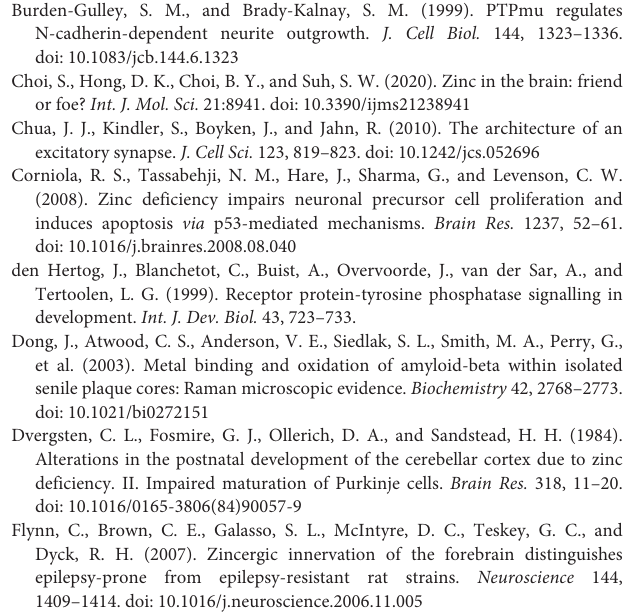
Supplementary Figure S1 | 50 µ MZn 2+ decrease both the excitatory and inhibitory synapse formation. (A) Representative images of neurons cultured with 0 µ M or 50 µ M Zn 2+ were fixed and labeled by vGult-1 (to mark excitatory synapses) and Tubulin antibodies (to mark neurons). The scale bar in the right lower corner applies to all images. (B,C) Summary graphs of excitatory synapse number (the number of vGult-1-specific puncta) and synapse size (the area of vGult-1-specific puncta) for all conditions as described for (A) . (D) Representative images of neurons cultured with 0 µ M or 50 µ M Zn 2+ were fixed and labeled by GAD65 (to mark inhibitory synapses) and Map-2 antibodies (to mark dendrites). The scale bar in the right lower corner applies to all images. (E,F) Summary graphs of inhibitory synapse number (the number of GAD65-specific puncta) and synapse size (the area of GAD65-specific puncta) for all conditions as described for (D) . Data information: numbers of neurons analyzed are at least 13. Data shown in summary graphs are mean values ± SEM. Statistical significance was analyzed by Student’s t -test. ** p < 0.01. Scale bar: 5 µ m. Supplementary Figure S2 | The heat map of differentially expressed gene. A heat map was made based on the amount of expression. The horizontal is the sample, and the vertical are the differentially expressed genes. Supplementary Figure S3 | The relative mRNA expression of the genes of PTPR family. The mRNA expression profiles of PTPR family determined by chip data from neurons cultured with or without Zn 2+ . Data shown in summary graphs are mean values ± SEM. Statistical significance was analyzed by Student’s t -test. * p < 0.05. Supplementary Figure S4 | The relative mRNA expression of PTPRM determined by qPCR. The mRNA expression was quantitative analyzed from the neurons cultured with or without 50 µ M zinc ions, infected with viruses expressing control vector or PTPRM. β -actin was used as the reference gene. Data shown in summary graphs are mean values ± SD, n = 3. Statistical significance was analyzed by Student’s t -test. * p < 0.05; ** p < 0.01; *** p <